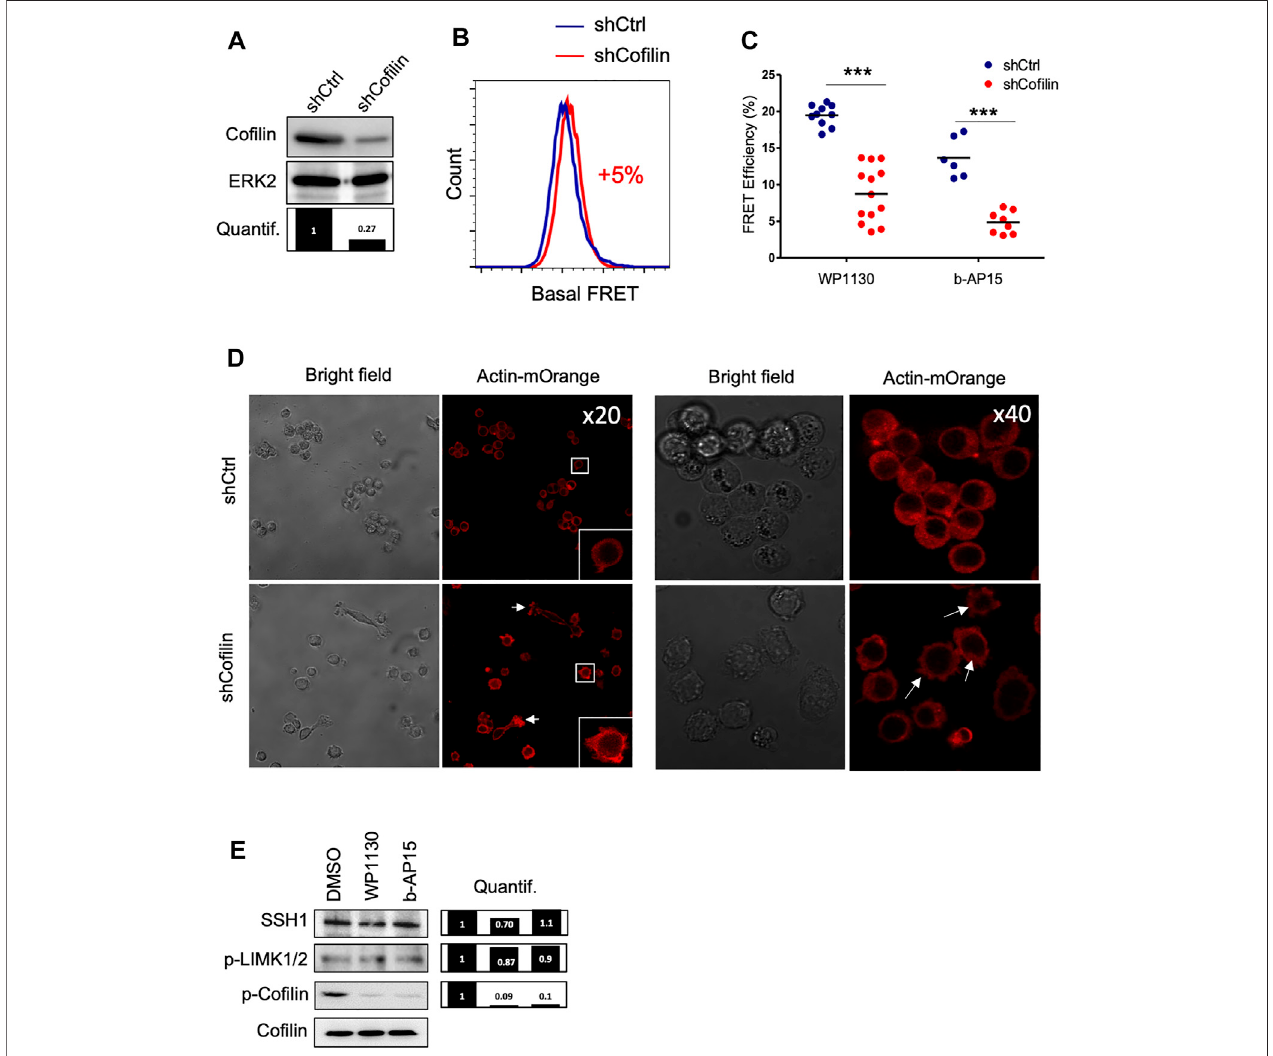
FIGURE 4 | Effect of co fi lin knockdown on DUBi-induced actin reorganization. (A) Immunoblot analysis showing co fi lin downregulation on Jurkat ACT cell line following stable transduction with shCtrl or shCo fi lin vectors. ERK2, loading control. Densitometric quanti fi cation to ERK2 signal is shown (lower panel). (B) Basal actin FRETmeasurementexpressingshCtrlorshCo fi linvectors.Dataarerepresentativeof n (cid:2) 5independentexperiments. (C) AnalysisofactinFRETef fi ciencyfollowingDUB inhibitiononshCtrlandshCo fi linACTcelllines.CellsweretreatedornotwithWP1130andb-AP15(15 µMeach)for30 minandFRETef fi ciencieswererecordedby fl ow cytometry. Data are expressed as the percentage of FRET ef fi ciency between DMSO-treated and compound-treated cells. Scatter plots show the mean of n (cid:2) 5 independentexperiments.*** p < 0.001,unpaired t -testsbetweenDMSOandeachtreatedcondition. (D) Confocalmicroscopyanalysisofactin-mOrangereorganization in shCtrl and shCo fi lin ACT cells. Scale bar, 20 µm. (E) Effect of WP1130 and b-AP15on SSH1 expression and LIMK1/2 and Co fi lin phosphorylation. Cells were treated for1 hat37 ° Cwiththeindicatedcompound(15 µM)andlysateswereanalyzedbyimmunoblottingwiththeindicatedantibodiesandquanti fi edbydensitometry analysis against total co fi lin signal (right